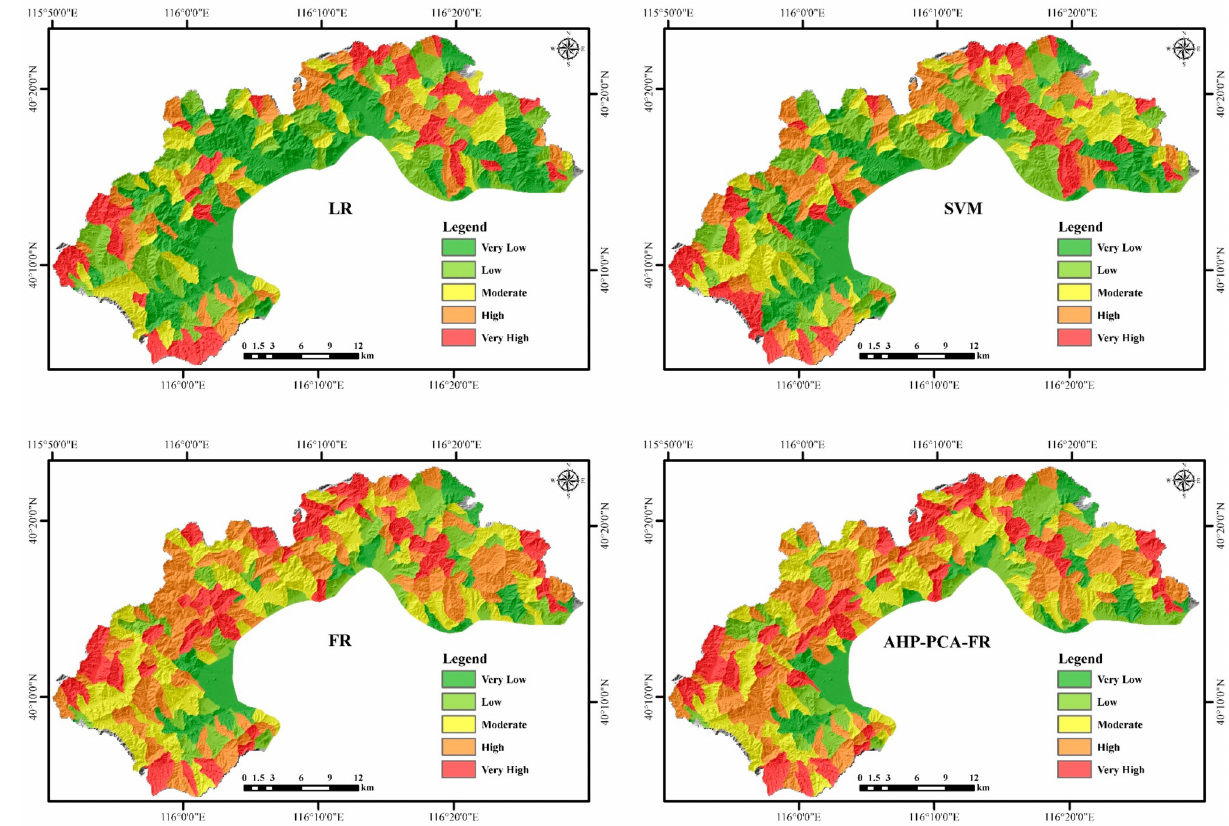
Figure 9. Debris flow susceptibility maps produced by four models.